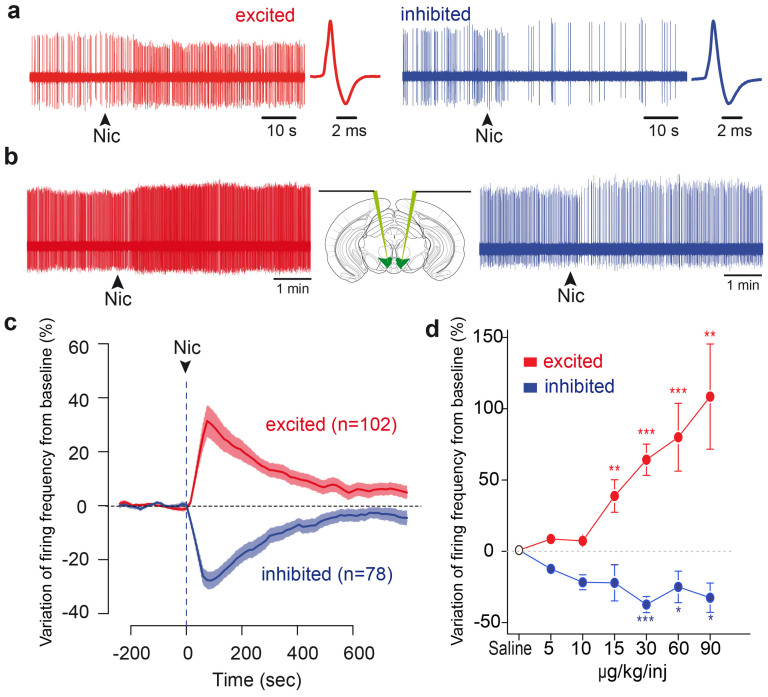
A subpopulation of VTA DA neurons is inhibited by nicotine.(a) Raw in vivo single cell extracellular recordings of an excited (left) and an inhibited VTA DA neuron (right) at the time of nicotine (30 μg/kg) intravenous injection (indicated by arrowheads). Corresponding wide action potentials, typical of DA neurons, are displayed on the right. (b) Schematic showing a mouse brain in which electrodes are lowered in both hemispheres. Raw extracellular simultaneous recordings of single DA neurons located in right and left VTA, at the time of nicotine (30 μg/kg) intravenous injection (arrowheads). This pair of neurons consists of an excited cell (red, left) and an inhibited cell (blue, right), showing that the responses to nicotine are not state dependent. (c) Mean responses of excited (red, n = 102) and inhibited (blue, n = 78) VTA DA neurons. Data, expressed as variation of firing frequency from baseline, are presented as mean (thick curves) ± SEM (light curves). Arrowhead represents the time of nicotine injection. (d) Mean responses of excited (red) and inhibited (blue) VTA DA neurons to increasing doses of nicotine (excited at 5 μg/kg: n = 8, 10 μg/kg: n = 8, 15 μg/kg: n = 10, 30 μg/kg: n = 50, 60 μg/kg: n = 18, 90 μg/kg: n = 10; inhibited at 5 μg/kg: n = 2, 10 μg/kg: n = 5, 15 μg/kg: n = 5, 30 μg/kg: n = 27, 60 μg/kg: n = 15, 90 μg/kg: n = 4). Similar results are obtained whether considering a single neuron's response at different doses or when considering the mean response of the populations. (* p < 0.05, ** p < 0.01, *** p < 0.001)